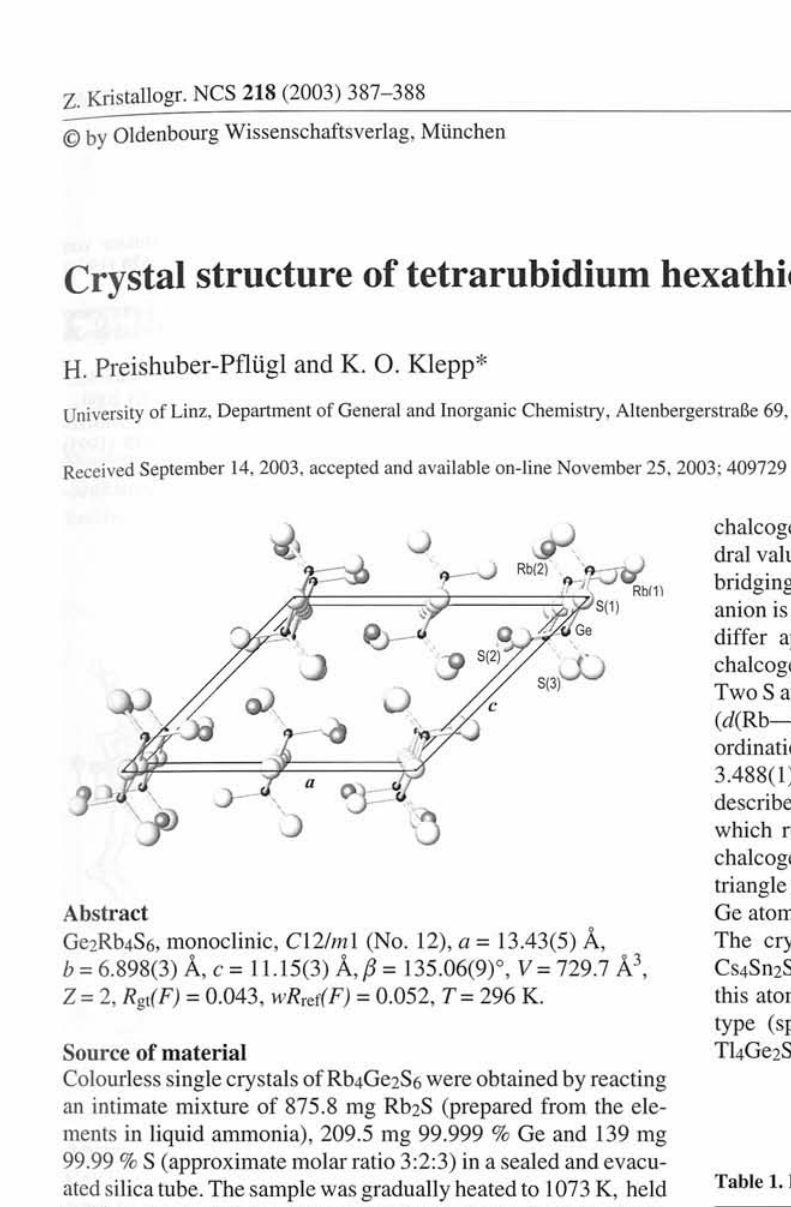
colourless, irregular fragment, size 0.15x0.18x0.20 mm